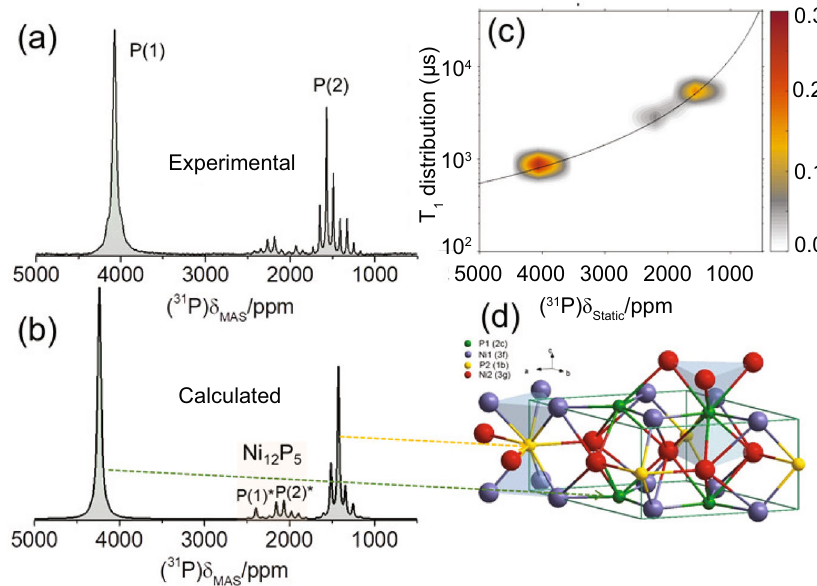
Fig. 1 31 P ssNMR, spin – lattice relaxation analysis and DFT-calculated spectra of microcrystalline Ni 2 P. a 31 P NMR spectrum of microcrystalline Ni 2 P at 14 kHz MAS. b Simulated 31 P MAS NMR spectrum with the DFT-calculated Knight shifts. c Spin – lattice relaxation times T 1 vs. NMR frequency for microcrystalline Ni 2 P under static conditions. The superimposed curve is fi tted according to the Korringa relation (Eq. S3 in Supplementary Note 5). d Visualization of the crystallographic unit cell and its nonequivalent Ni and P